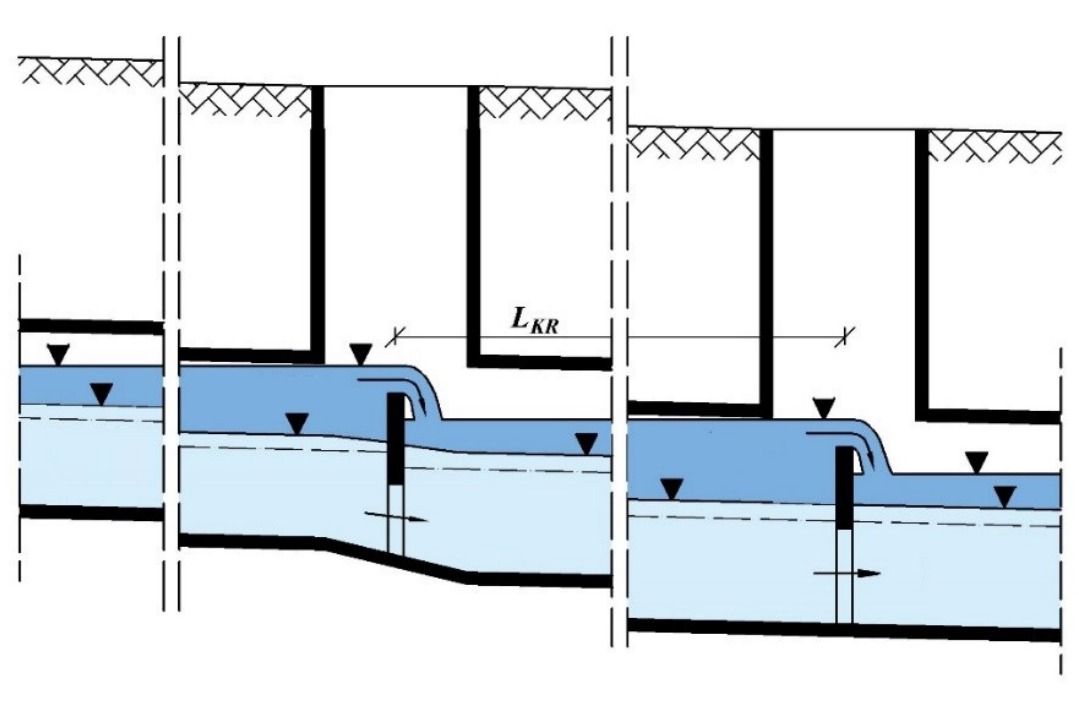
Figure 5: Scheme of the retention sewage canal with damming partitions that create stormwater canal retention spaces (the light blue - average distribution of the liquid stream mirror in the conduits of a traditional rainwater systems; the blue - liquid stream distribution and retention capacity of the rainwater sewage system after equipping it with damming partition), L partitions